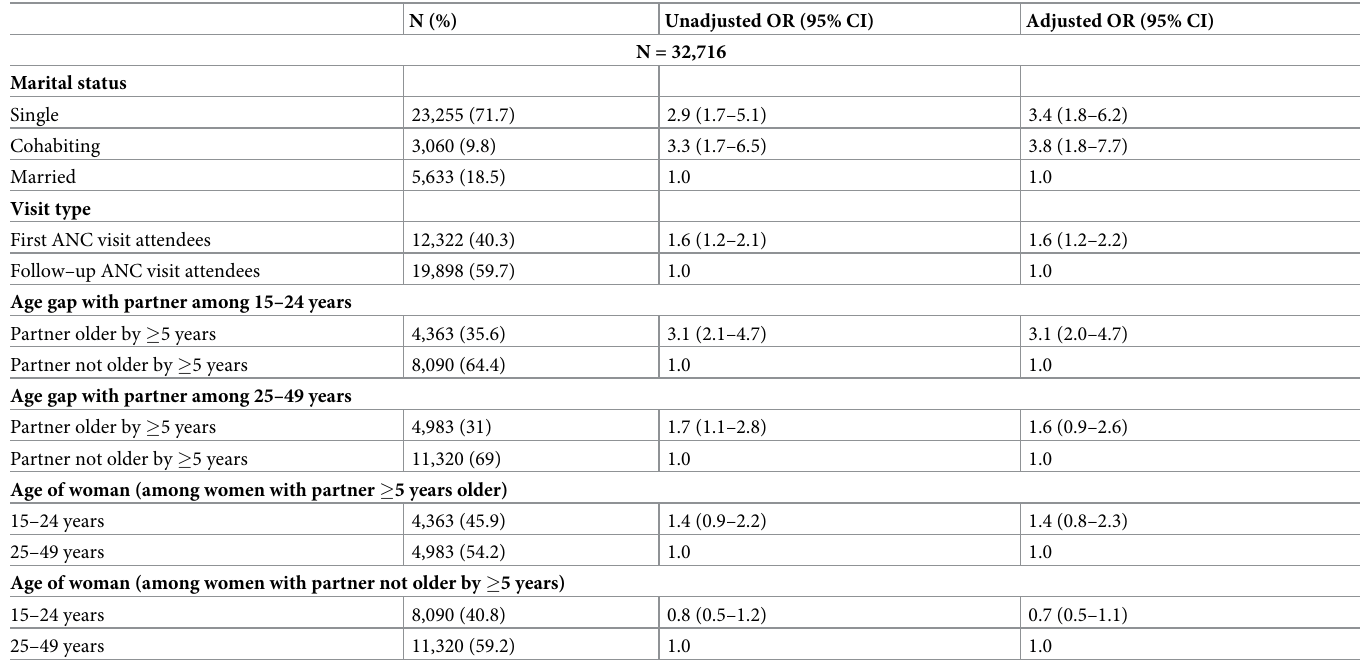
Table 2. Factors associated with recent HIV infection (reference group for comparison: HIV negative) in the 2017 Antenatal HIV Sentinel Survey, South